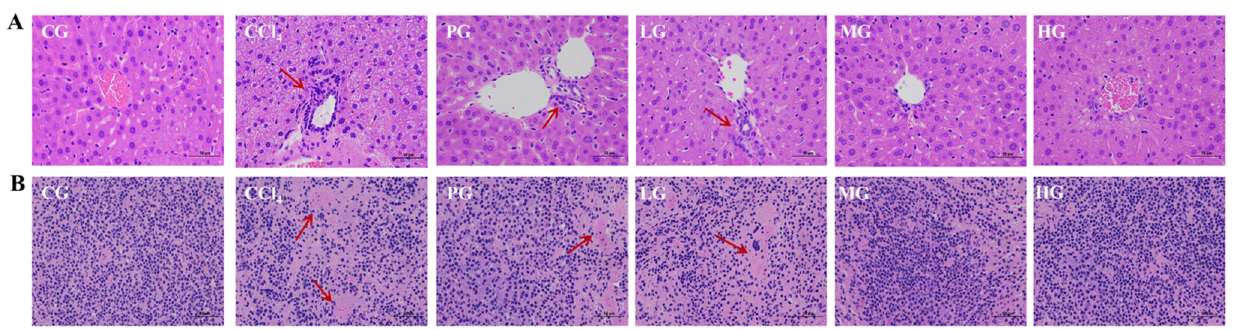
Figure 3. Effect of the ethanol extract of G42 on histopathological changes of liver and spleen caused by CCl 4 . ( A ) Liver and ( B ) spleen. (Scale bar: 50 μm; magnification: 400×).